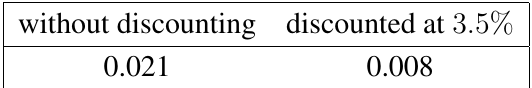
Table 1. Seasonal component June-2009 to June-2021 ($/million Btu